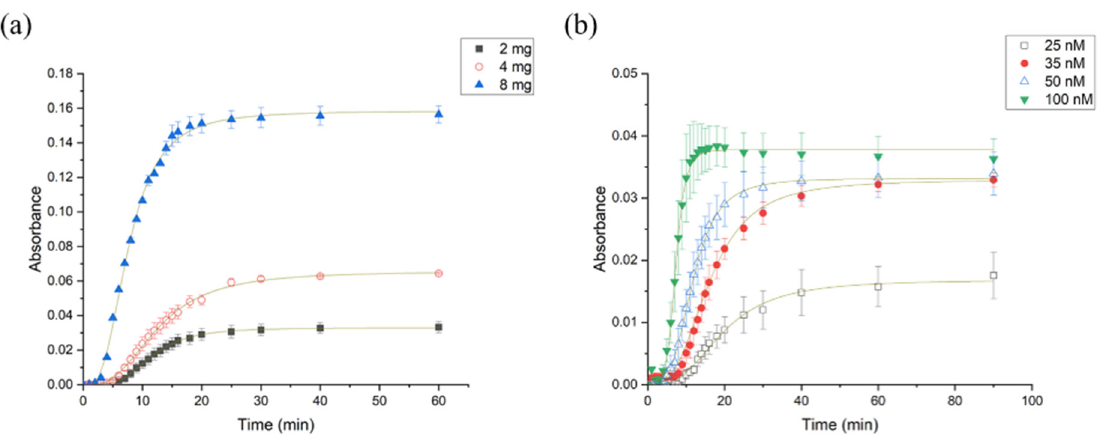
Figure 6. Kinetics of the reaction of X-Gluc grafted PUAA-ADH with ß-GUS followed at a wavelength of 615 nm, ( a ) varying the substrate concentrations (using 2 mg, 4 mg, 8 mg of the 40 µ m cuboid hydrogel films, 50 nM ß-GUS); ( b ) varying the β -GUS concentration (25 nM, 35 nM, 50 nM and 100 nM for a 40 µ m cuboid hydrogel film (error bars: standard error of the mean, n = 3).